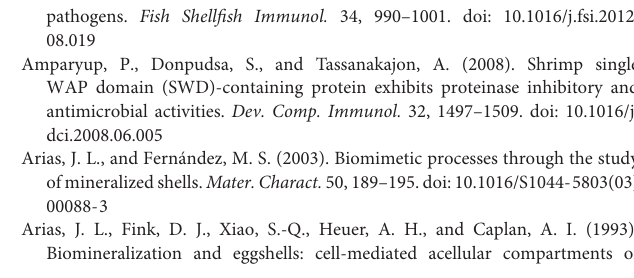
FIGURE S1 | Pooled barnacle secretion sample and corresponding bands cut for the in-gel trypsin digestion in experimental series 1. FIGURE S2 | Standard curves shown with 1 and 10 mM L-dopa and varying concentrations of tyrosinase for the two experiments, both with glue and inhibitors (A,B) and with heated glue (C,D) . Error bars indicate the standard deviation of triplicate conditions. TABLE S1 | Distribution of enzyme classes present in the proteome database, highlighting two subclasses of interest, oxidoreductases and hydrolases and number of sequences within each